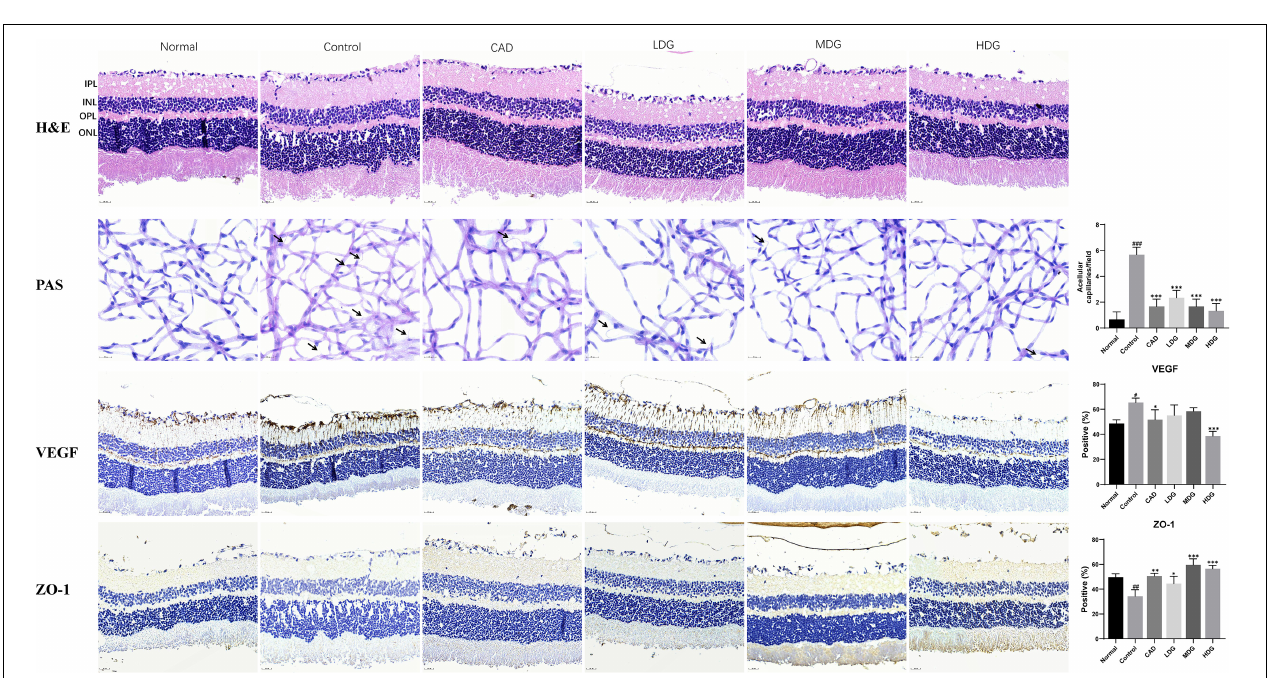
FIGURE 3 | Bie-Jia-Ruan-Mai-Tang (BJ) inhibits retinal angiogenesis in diabetic mice. The H and E, PAS, and immunohistochemistry staining were used to investigate the effects of BJ on retinal structure, acellular capillaries formation, and related protein expression in diabetic mice. The acellular capillaries in each field were counted, and the immunohistochemistry staining for VEGF and ZO-1 was quantified by calculating the positive area. IPL: inner plexiform layer, INL: inner nuclear layer, OPL: outer plexiform layer, ONL: outer nuclear layer. The arrows indicate acellular capillaries. Data are represented as mean ± SD ( n = 8). # P < 0.05, ## P < 0.01, ### P < 0.001 vs. Normal; ∗ P < 0.05, ∗∗ P < 0.01, ∗∗∗ P < 0.001 vs. control.